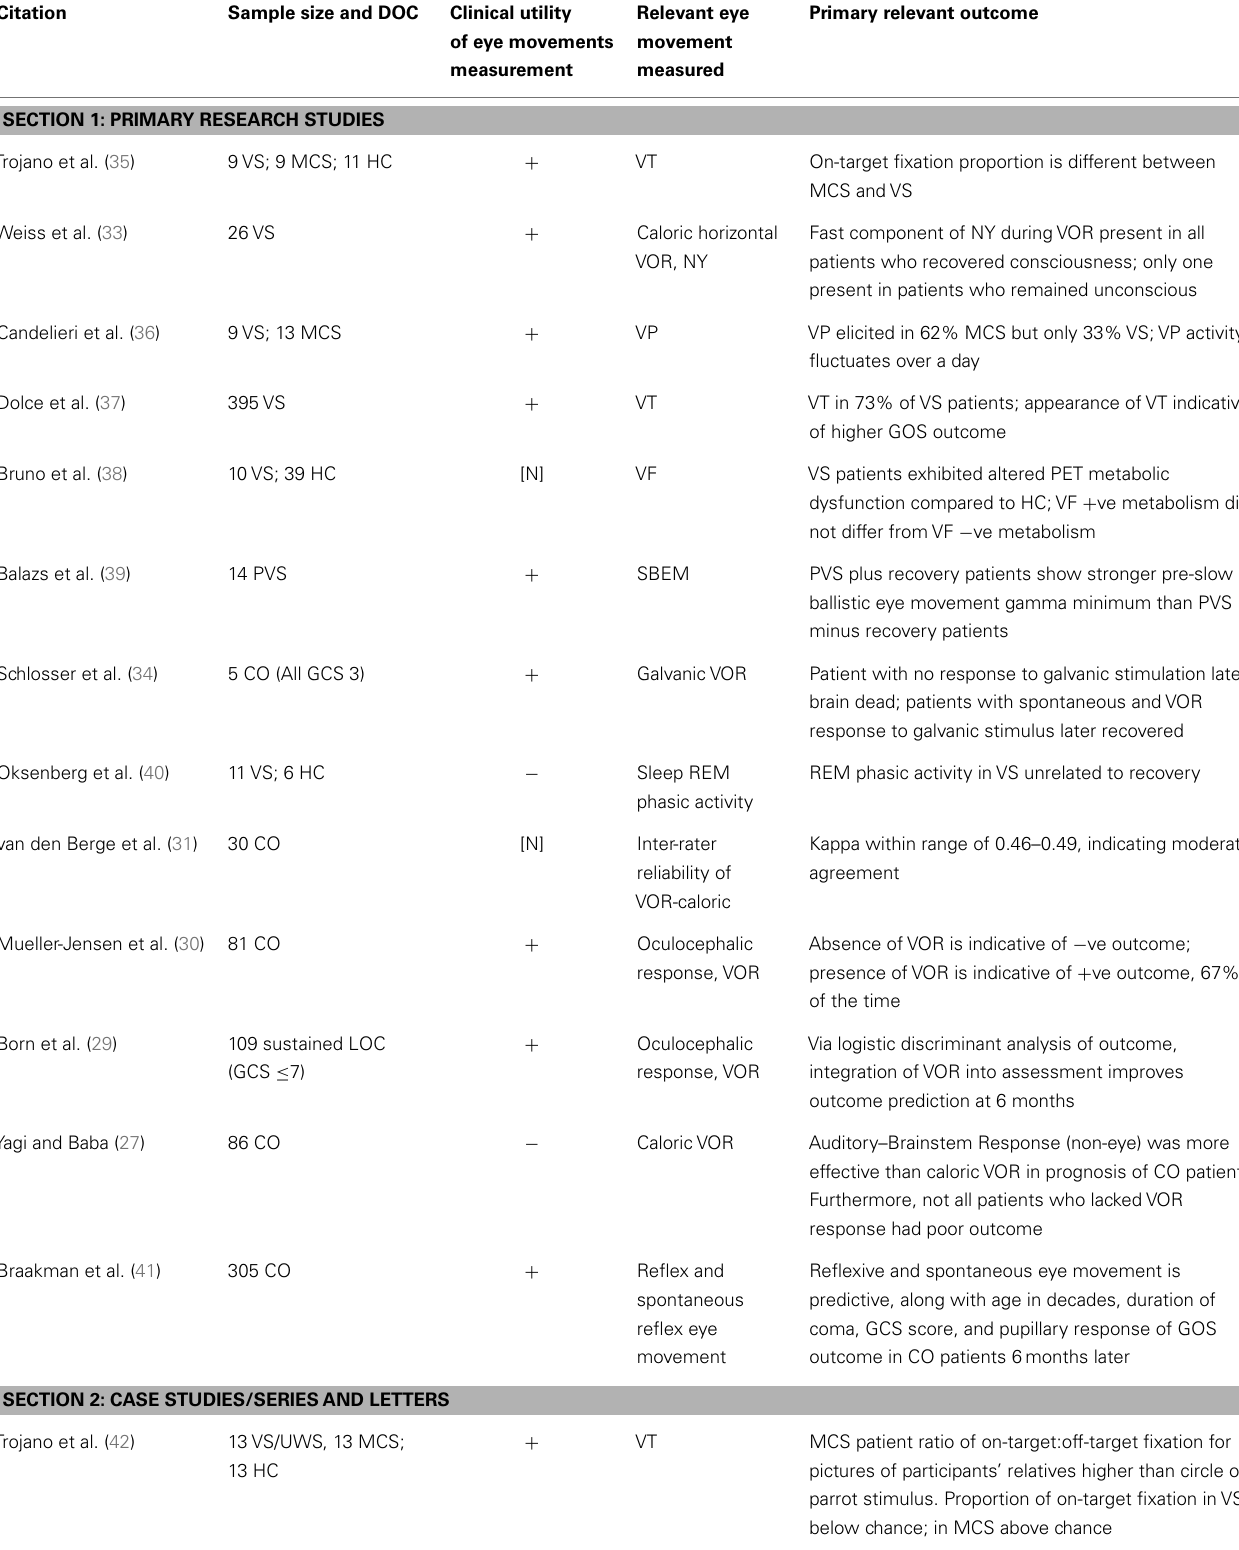
Table 1 | Literature investigating eye movement measurement in disorders of consciousness